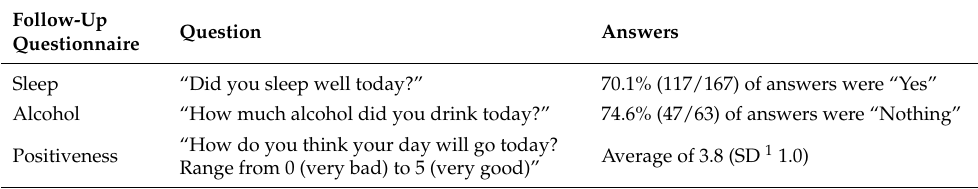
Table 3. Results related to the follow-up questionnaires (sleep, alcohol, and positiveness).